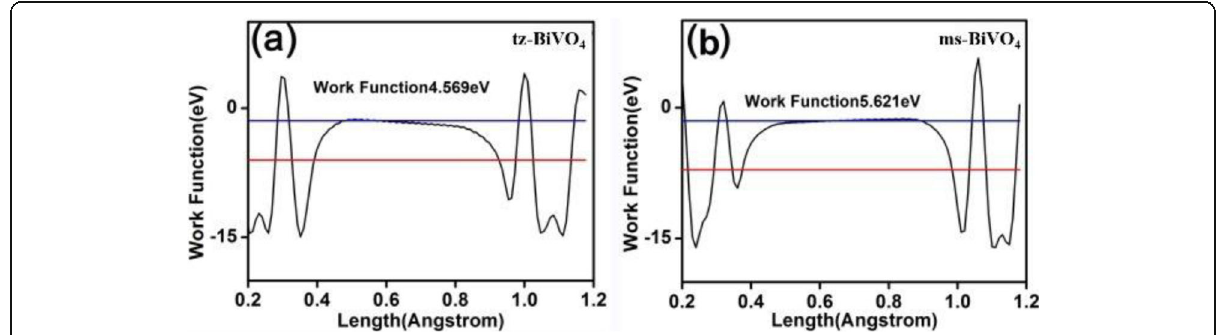
Fig. 4 The work function of pristine tz-BiVO 4 ( a ) and pristine ms-BiVO 4 ( b